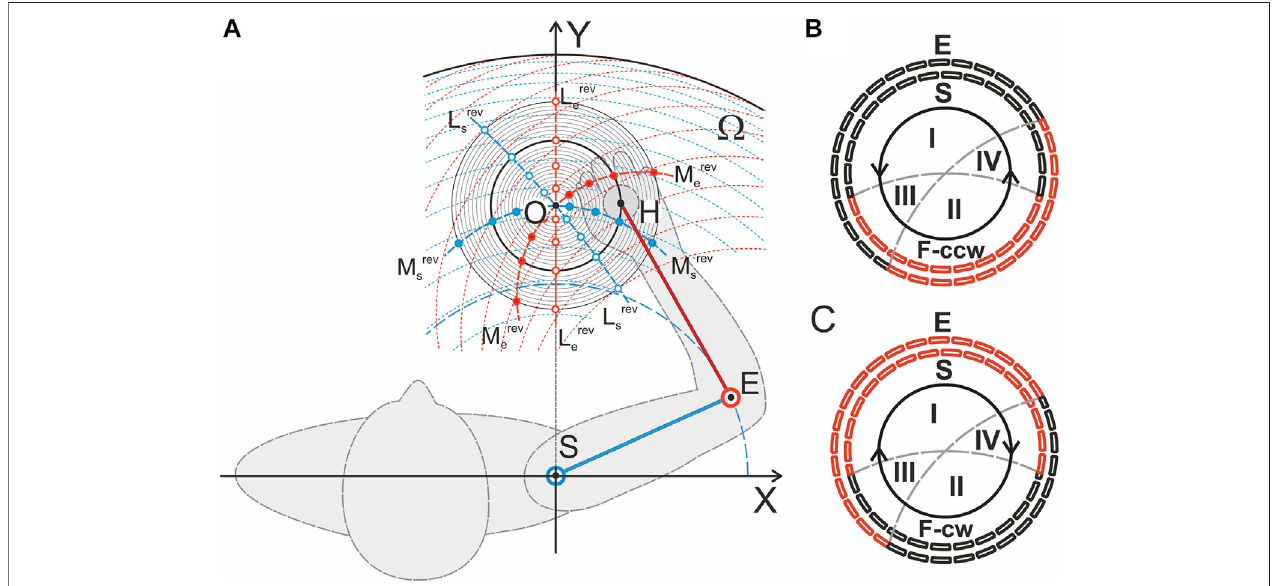
FIGURE 1 | Experimental setup. (A) Geometry of the test movements; the respective graphs are built in a scale for the subject YK, for whom the tomographic identi fi cation of the joint bones had been preliminarily performed (Gorkovenko et al., 2020). The center of the circle of movement (a thickened line in the family of concentric circles, R= 10 cm) waslocated on a lineperpendicular tothe frontal plane passing through theaxis ofthe subject ’ s right shoulder joint; the distance from the circle center to the joint center was 40 cm, and the lengths of the SE and EH segments were 28 and 32 cm, respectively (the distances can be used as a scale for this Panel). The red dashed lines represent traces of movement in the elbow joint for a fi xed set of shoulder positions; the blue dashed lines show movements in the shoulder joint during stepwise fi xation of the elbow joint angle. Additionally, the reverse lines for the torques acting around the shoulder and elbow joints (M s,erev ) and for the directionsof themuscle length changes(L s,erev ) (Kostyukov, 2016) are shown in (B,C) . The segments ofthecircular movement where the fl exor (black) and extensor (red) muscles belonging to the shoulder (E, outer dashed circles) and elbow (S, inner dotted circles) joints actively contract to develop tangential forces in counterclockwiseF(ccw)orclockwiseF(cw)directionsareshown.SynergysectorsIandIIde fi nethezonesinwhichcombinationsoftheelbowandshouldermusclesof the same functionality ( fl exor- fl exor, extensor-extensor) are activated to create tangential forces; in sectors III and IV, the fl exor-extensor or extensor- fl exor pairs should beactive.Achangeintheforcedirection,F(ccw)onF(cw),andviceversaleadstoachangeinthepositionsoftheactivationsectorsbetweenthe fl exorsandextensorsof both